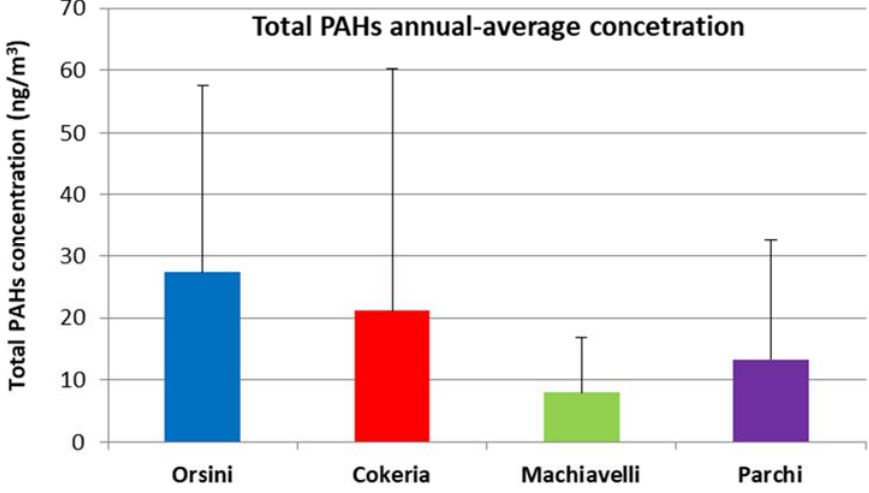
Figure 2. Polar plot of hourly total p-PAH concentrations (ng / m 3 ) monitored at seven sites included in the fence monitoring network of the steel plant from 1 August 2013 to 30 August 2014.